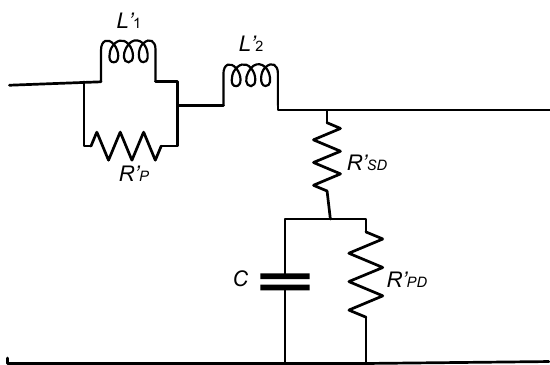
Figure 4. Schematic of the distributed capacitor model based on frequency characterization of the dielectrics.